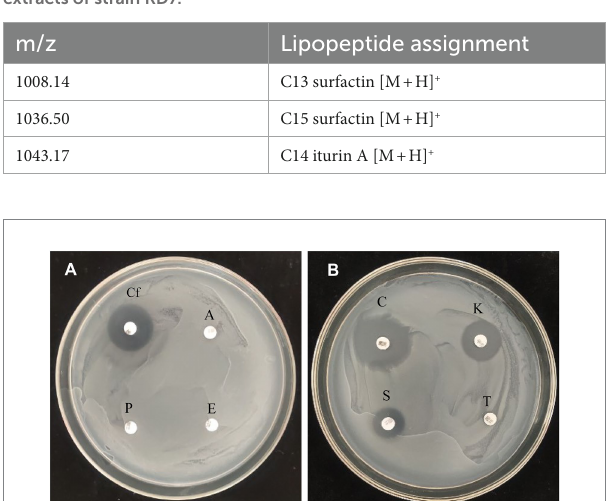
TABLE 2 HRMS (ESI) analysis of antagonistic lipopeptides from the crude extracts of strain KD7.